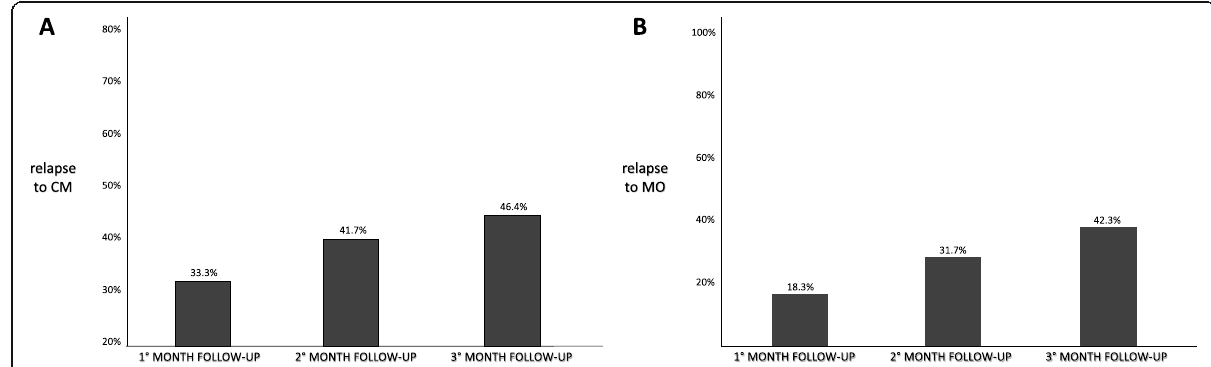
Fig. 4 The frequency of patients relapsing to CM (A) and MO (B) MMDs in the three months of mAbs anti-CGRP pathway